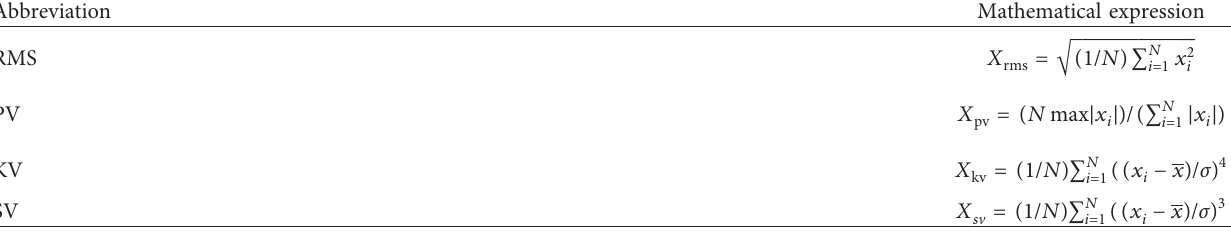
Table 1: Time-domain indicators.